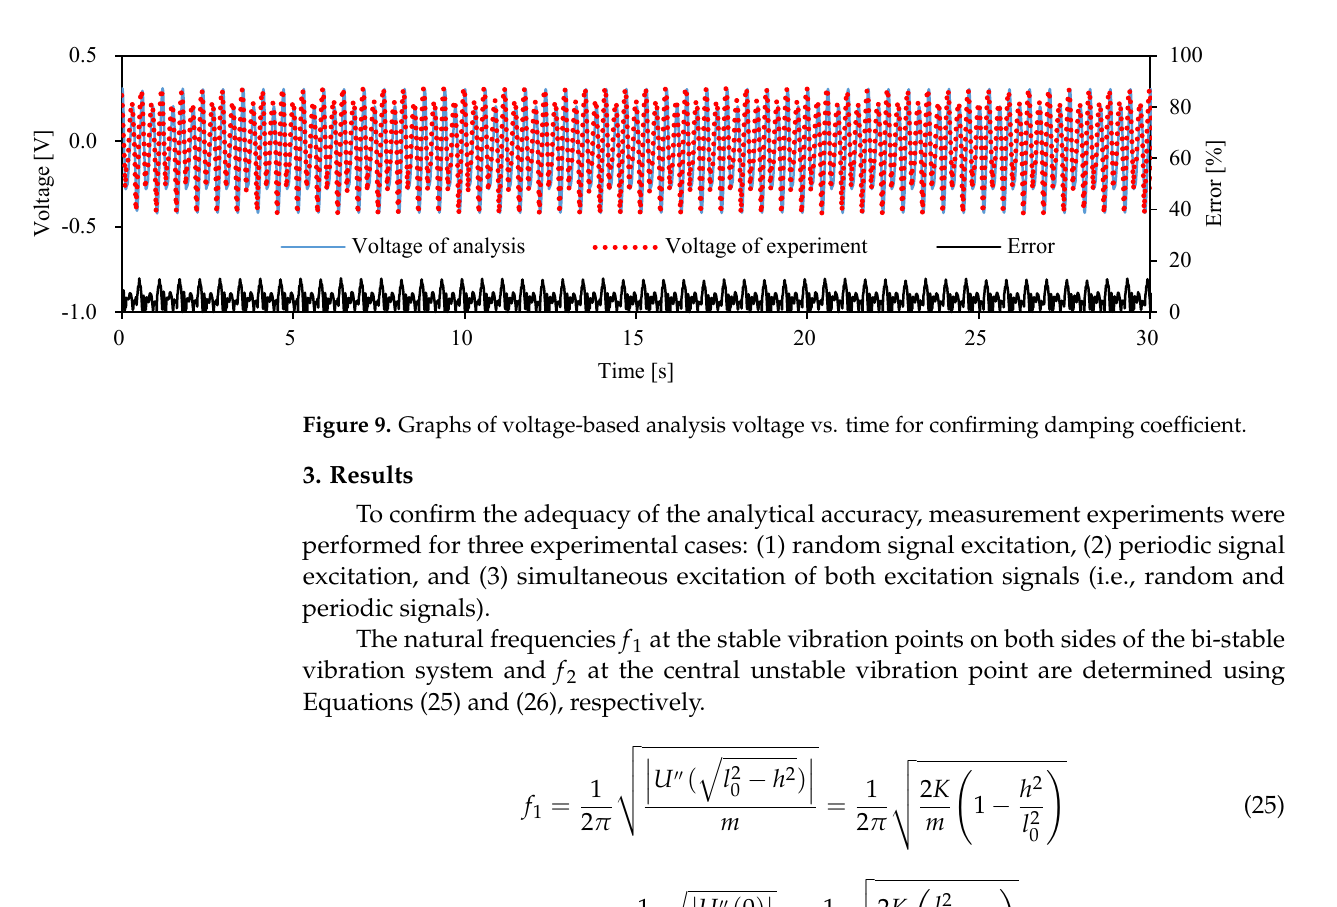
Figure 8. Graphs of displacement based numerical analysis vs. time for confirming damping coeffi- cient.